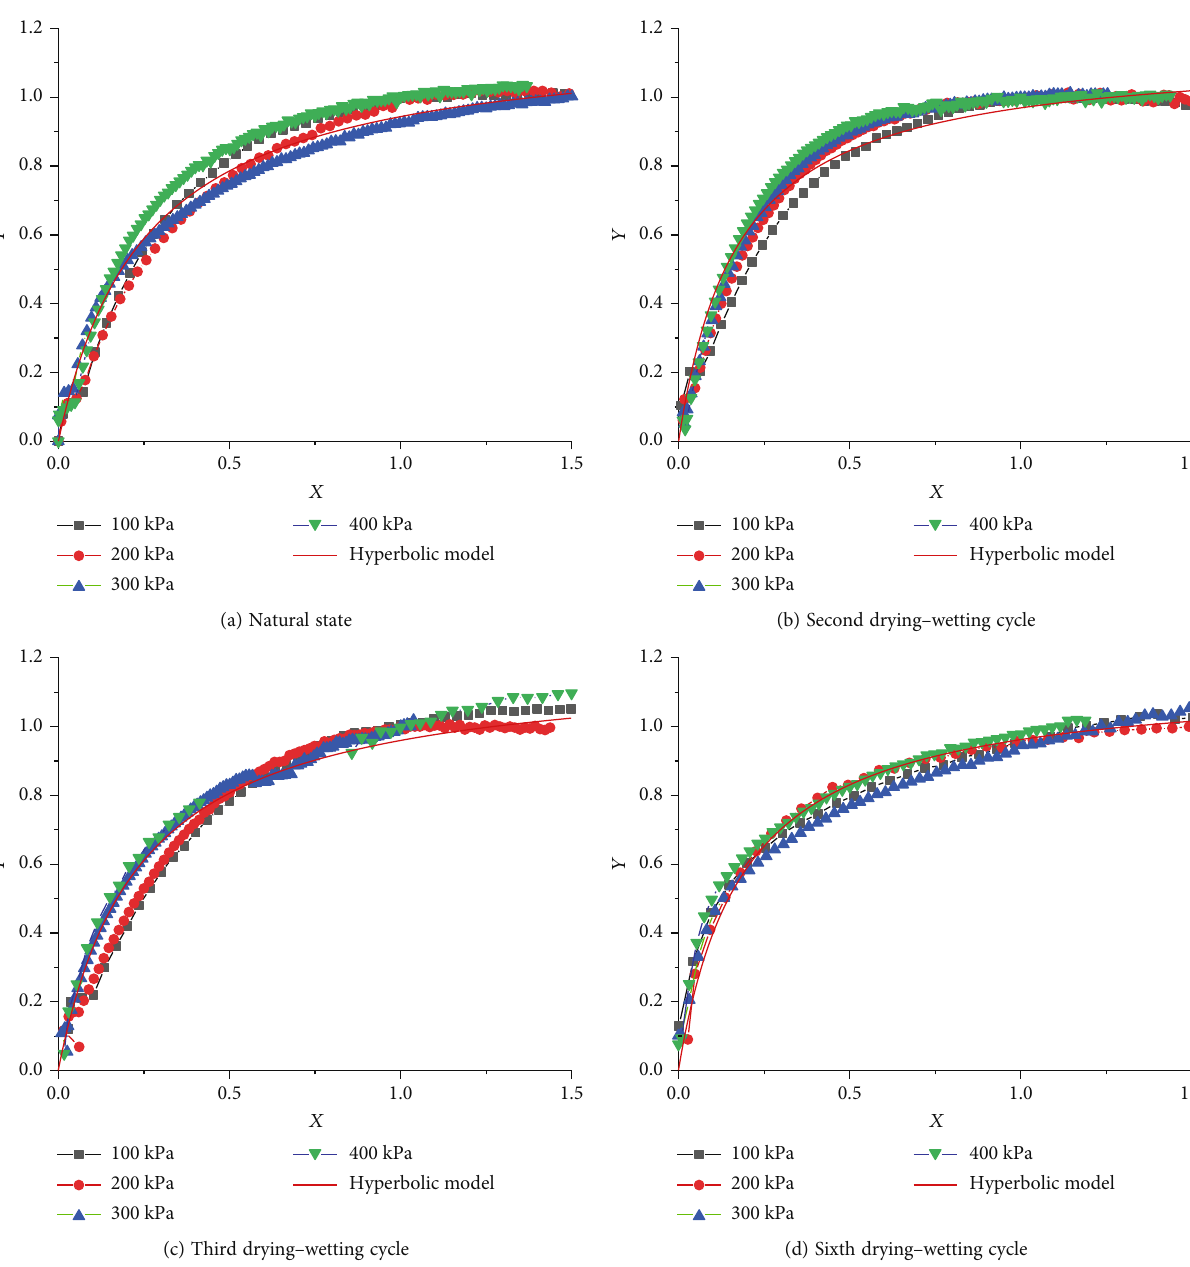
Figure 12: Fitting results of the hyperbolic